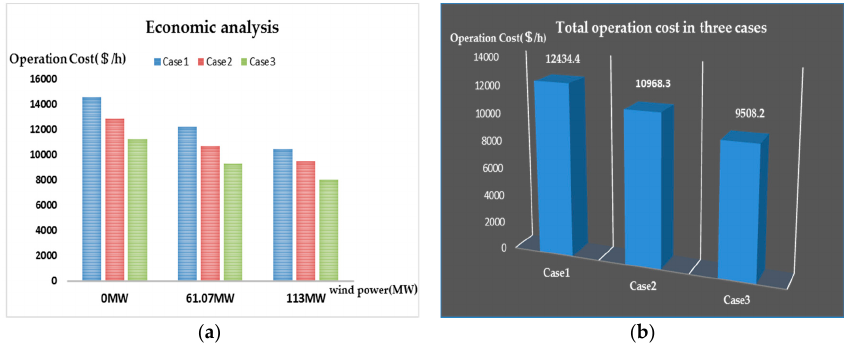
Figure 7. ( a ) Operation cost with consideration of wind distribution; ( b ) Total operation cost in three cases.